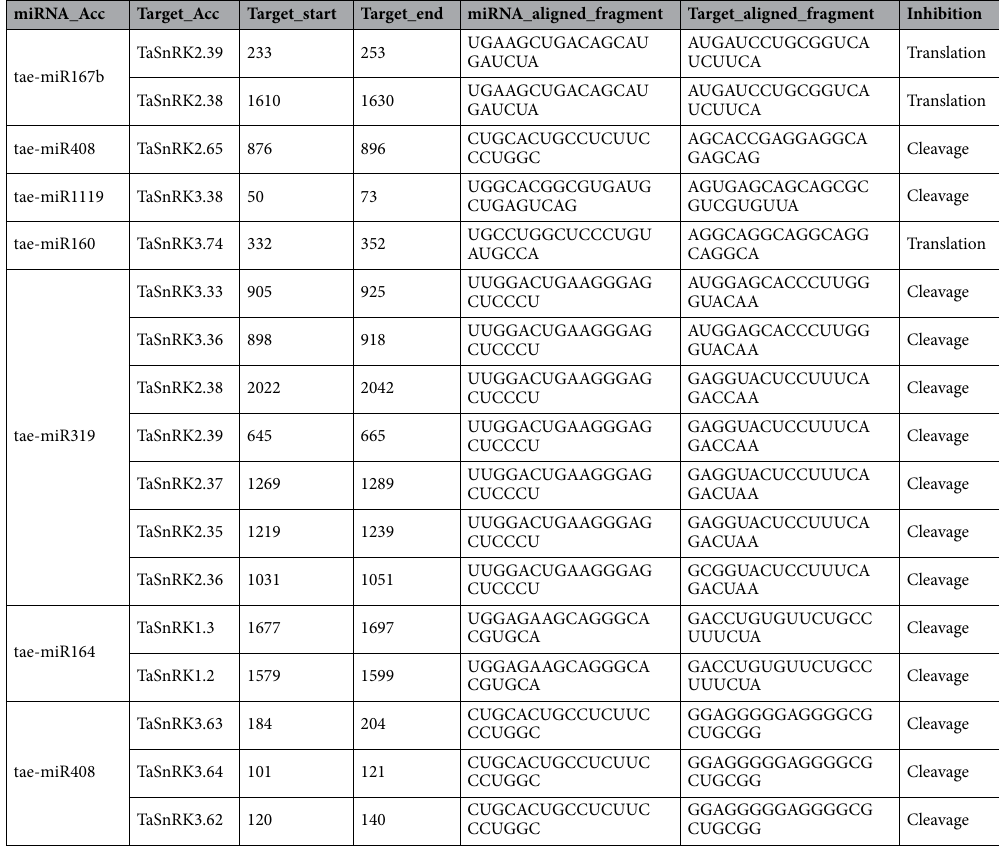
Table 2. Prediction Tae-MIR genes and their targets by using the psRNATarget server with default